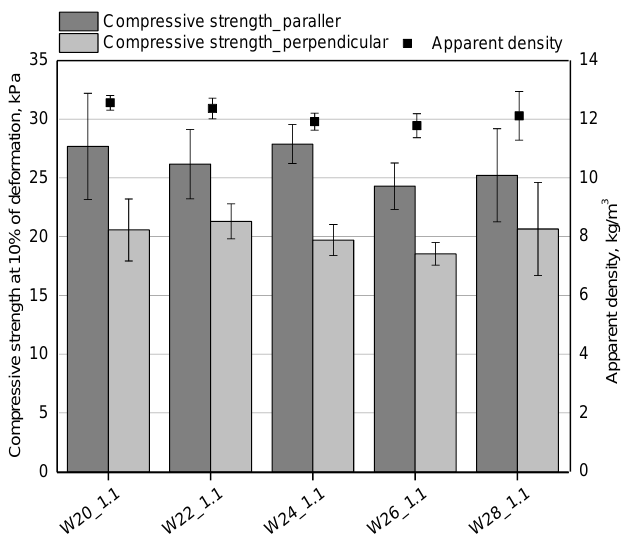
Figure 5. The apparent density and compressive strength of open-cell PUR foams obtained with different amounts of water.